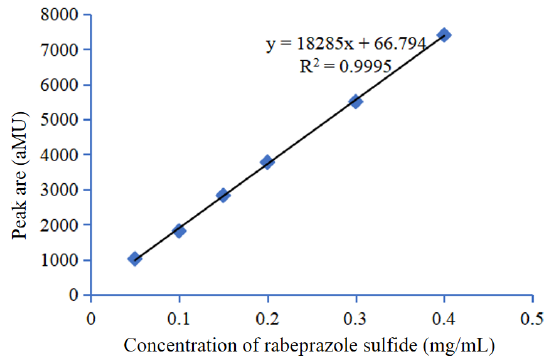
Figure 3. Standard curve of rabeprazole